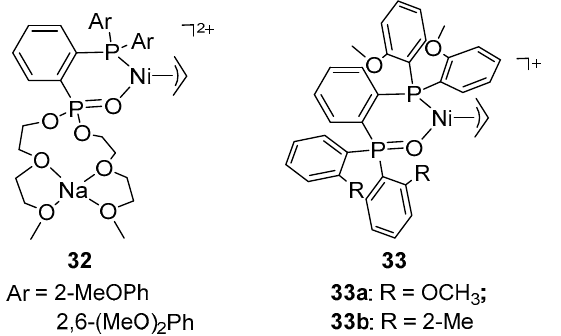
Figure 29. Cation-tunable Ni (P, O-donor) catalysts 32 and 33a , b developed in the Do laboratory.